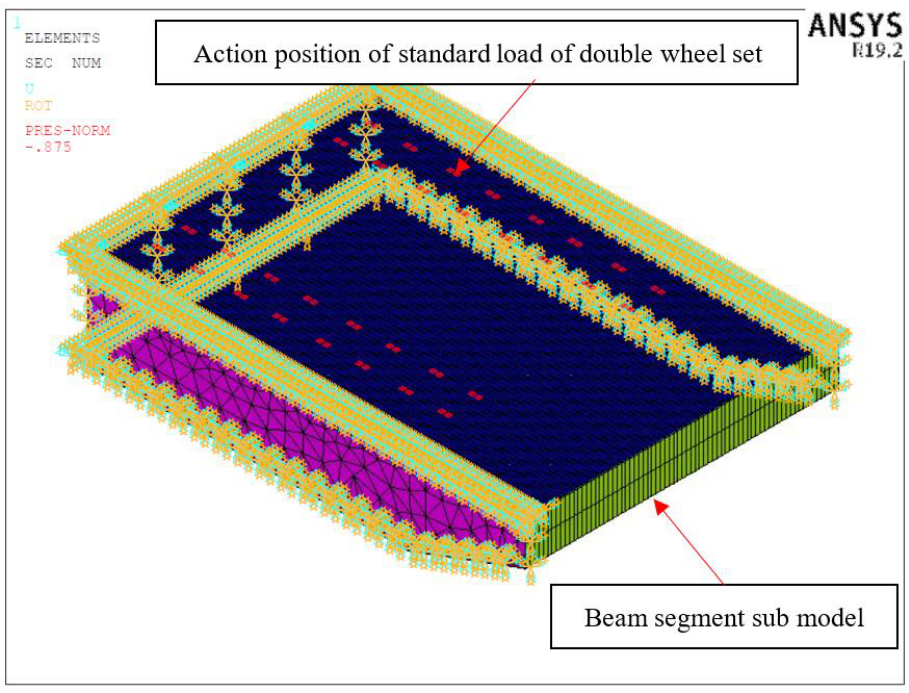
Figure 3. Numerical simulation and calculation model of partial beam segment submodel in Nansha Bridge Dasha Waterway Bridge.